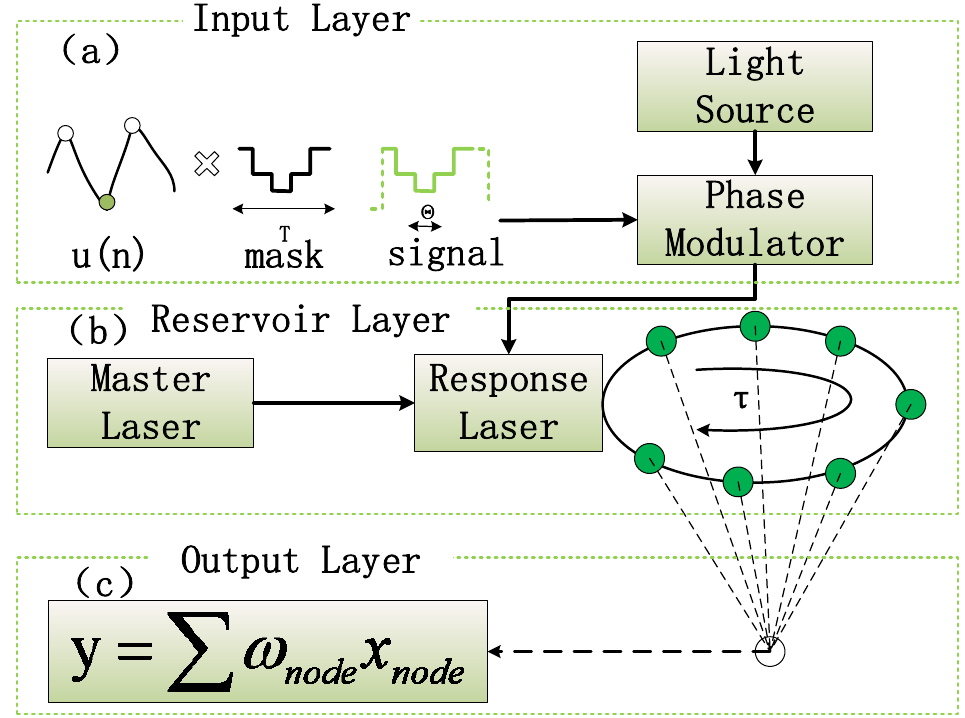
Figure 1. Schematic of the proposed system including ( a ) input layer, ( b ) reservoir layer, ( c ) output layer. Table 1. Values of laser